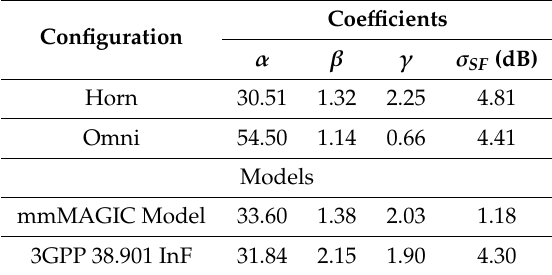
Table 3. LOS ABG fitting and mmMAGIC coe ffi cients.